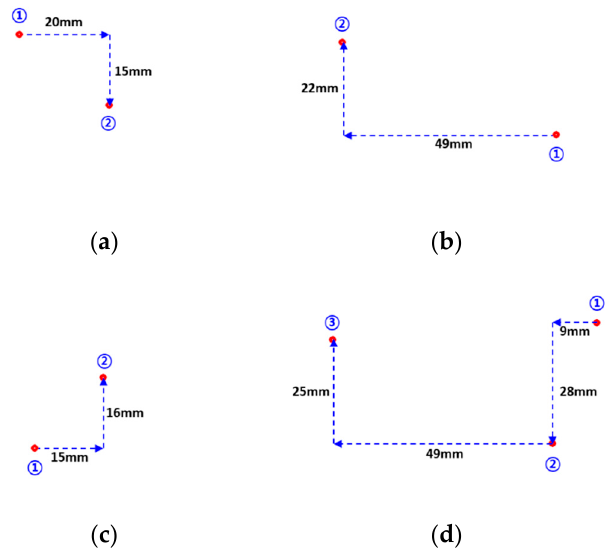
Figure 17. Experiment 2 for proposed system and algorithm verification ( a ) 1st experiment path ( b ) 2nd experiment path ( c ) 3rd experiment path ( d ) 4 th experiment path. Table 4. Analysis of contact location along the travel path.